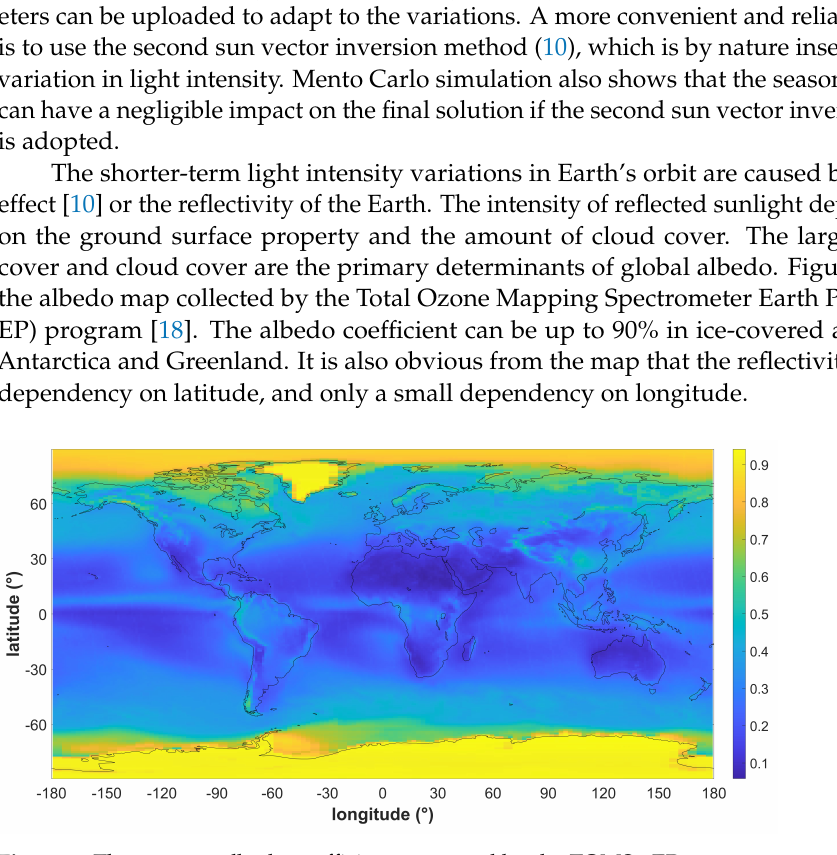
Figure 9. The average albedo coefficient measured by the TOMS − EP